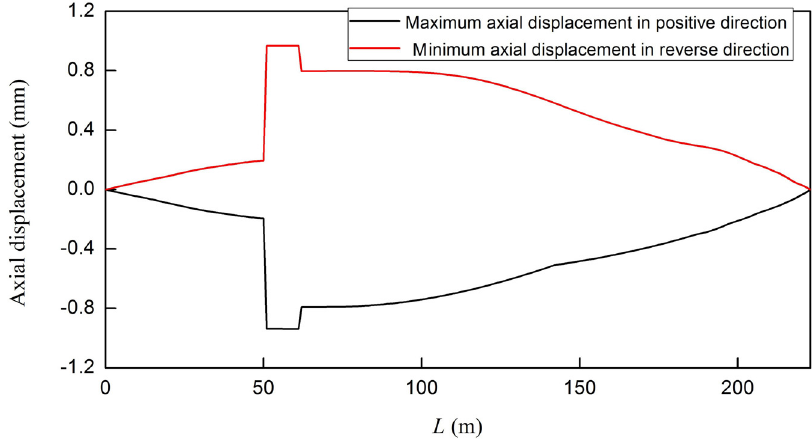
Figure 10. Amplitude of original modes of axial displacement of pipe produced by surge and closed valve.